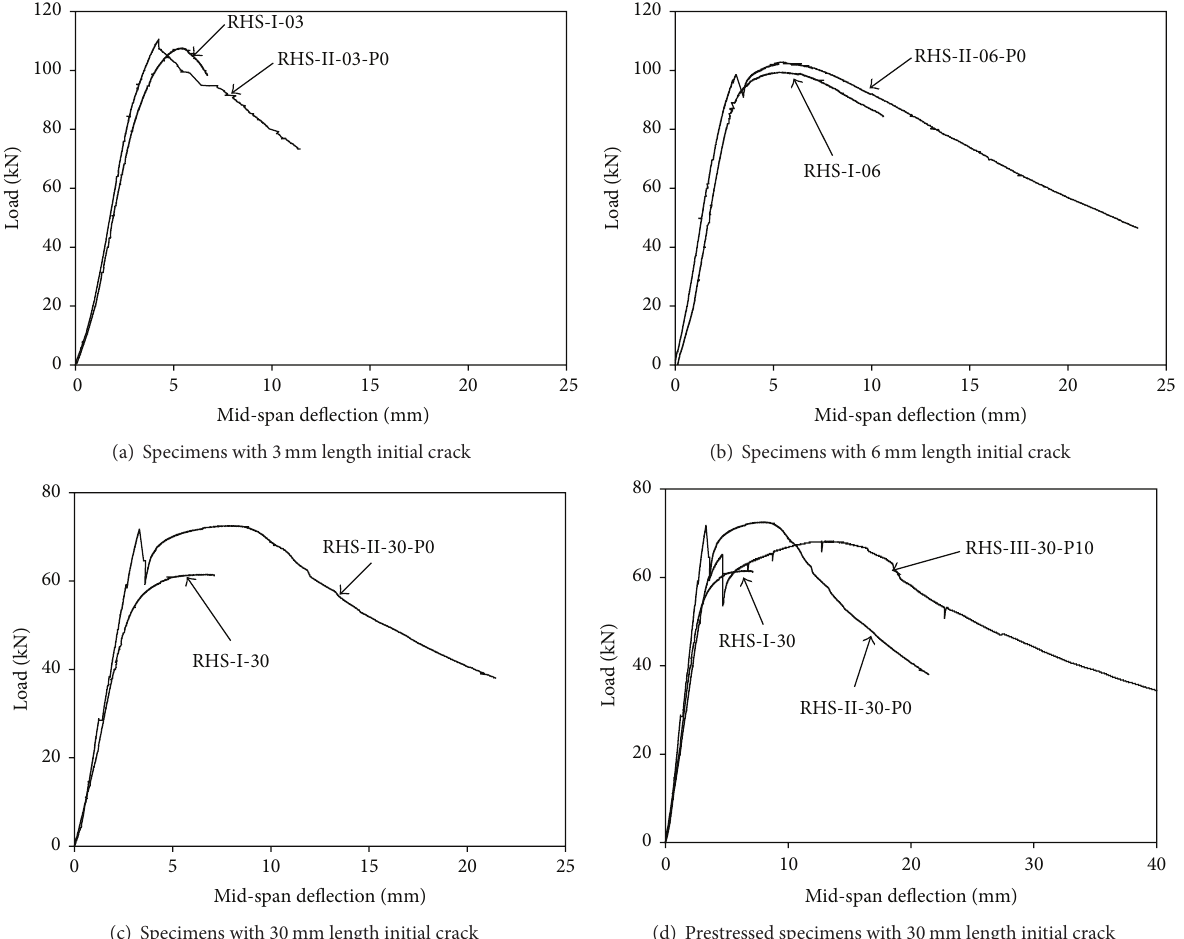
Figure 5: Load versus mid-span deflection